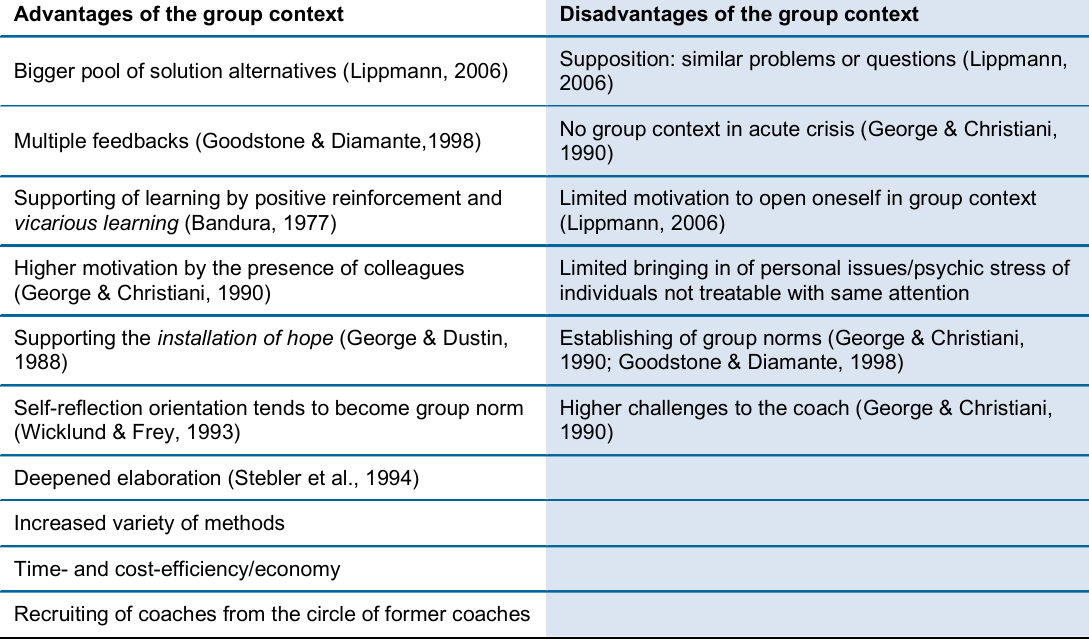
Table 1: Advantages and disadvantages of the group context (table reproduced with permission from Ebner, 2013, p. 198, translated by the author